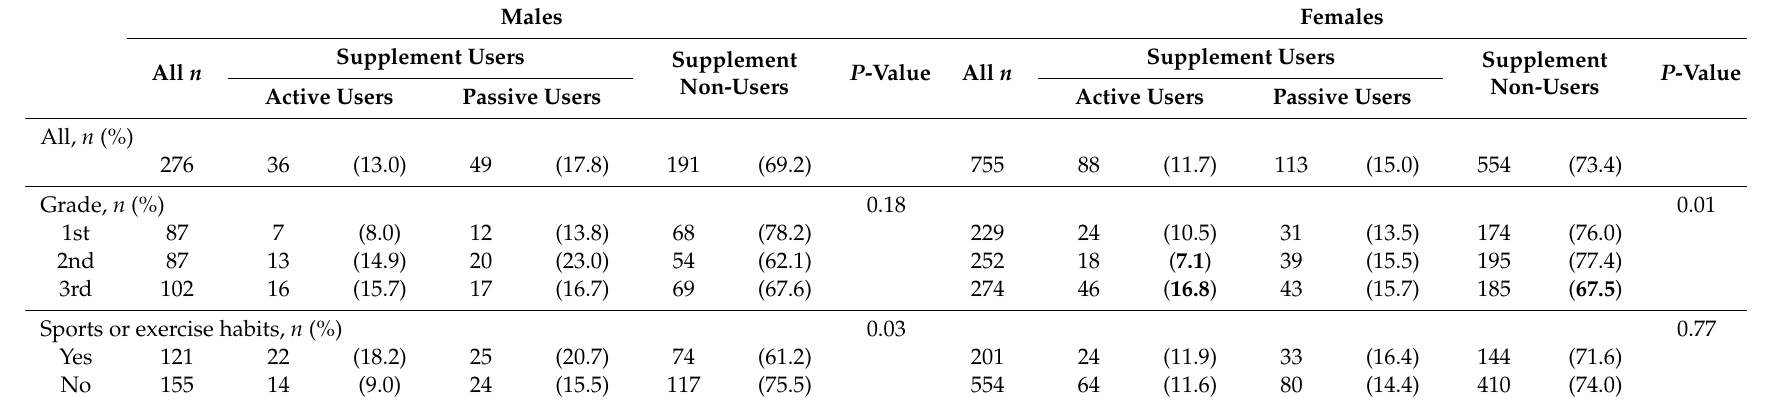
Table 1. Characteristics of survey participants according to sex and the use of dietary supplements.